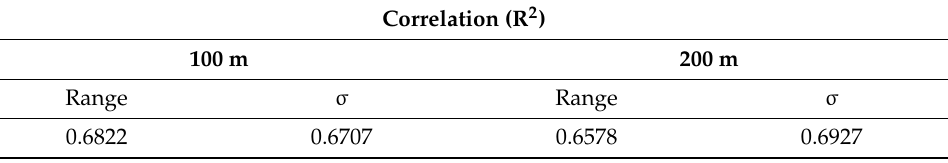
Table 1. Correlation (expressed as the coefficient of determination R 2 ) when describing SDS variability as a function of grain size (following Ec. 1, n = 137). Different variability proxies and segment lengths are considered. All p-values equal